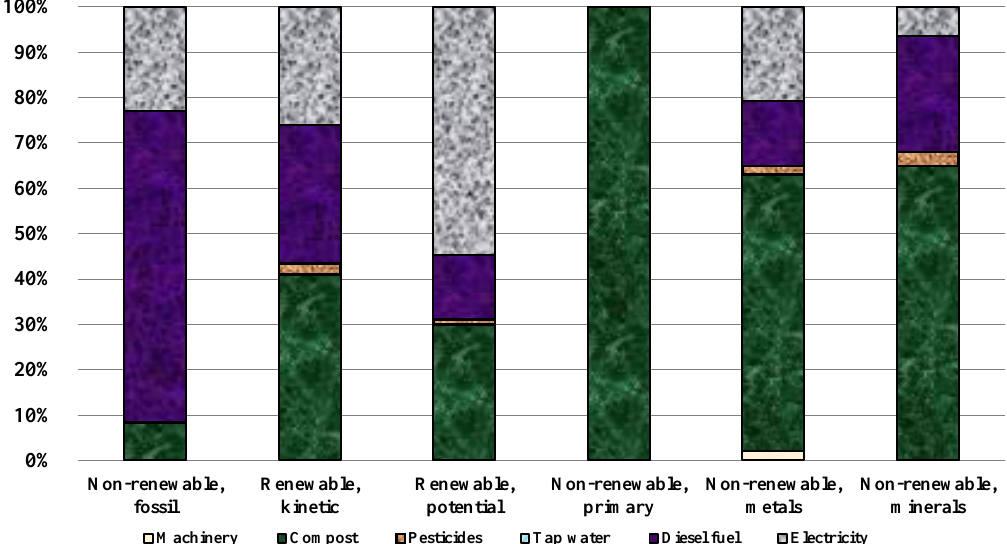
Figure 6. Percentages of different input energy forms for CExD in mushroom production.